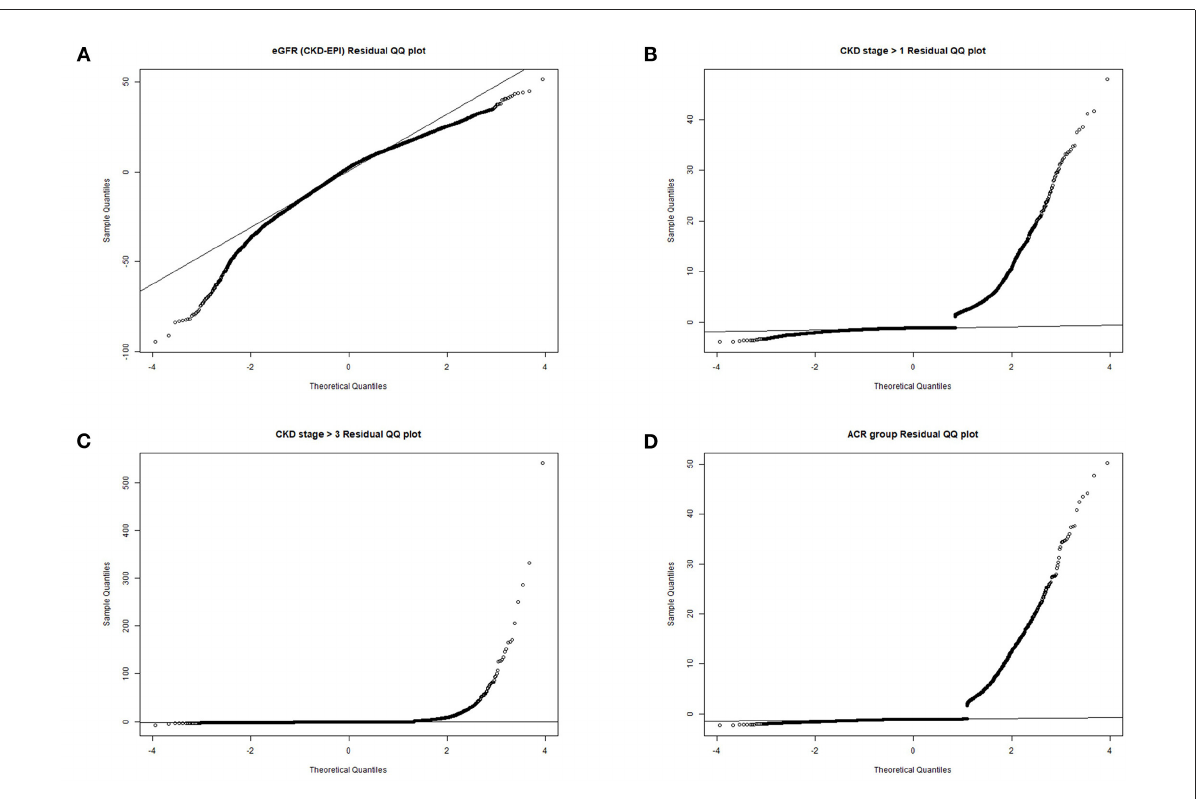
a ModelI:adjustedforage,gender,race,ratioofincome-poverty,educationallevels,andmaritalstatus. b Model II: adjusted for age, gender, race, ratio of income-poverty, educational levels, marital status, BMI, CAD score, smoking, alcohol, physical activity, serum calcium, and serumphosphorus.